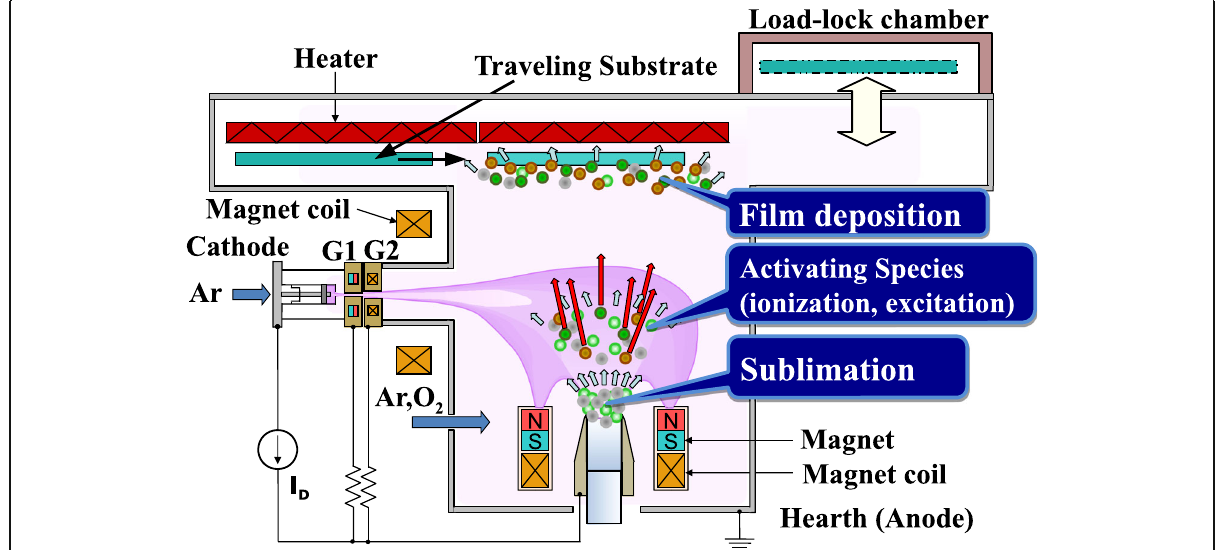
Fig. 1 Schematic diagram of RPD with DC arc